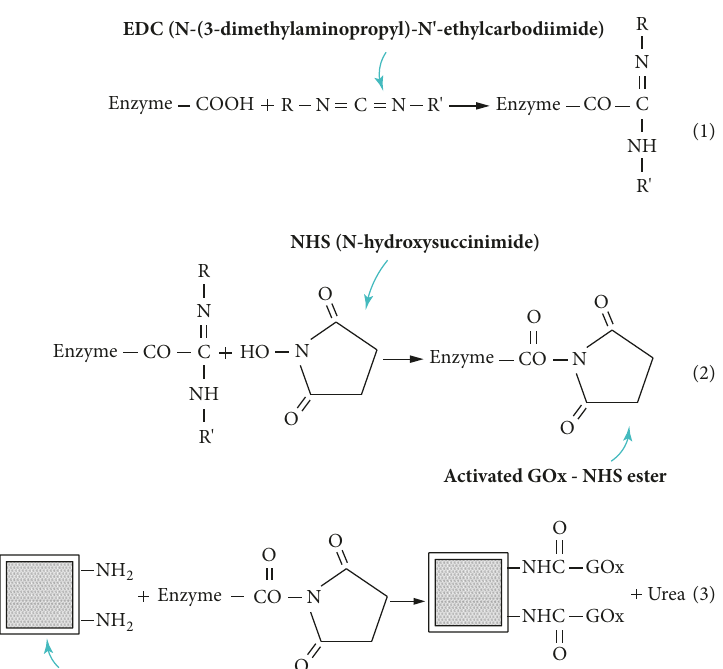
Figure 2: EDC, NHS, and GOx reaction mechanism for activated and stabilized